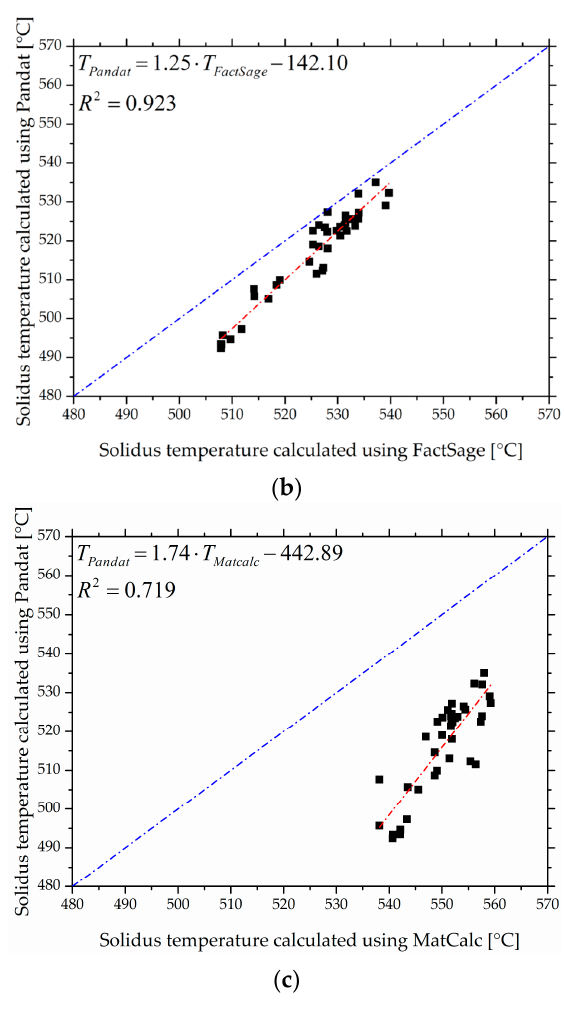
Figure 2. Comparison of solidus temperatures predicted by CALPHAD programs: ( a ) FactSage ® vs. MatCalc; ( b ) FactSage ® vs. Pandat™; and ( c ) MatCalc vs. Pandat™.